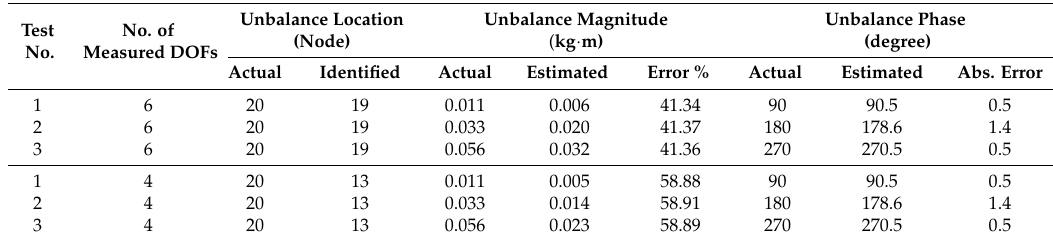
Table 6. Unbalance magnitude and phase estimation for the steel tube roll using equivalent load minimization using six and four measured